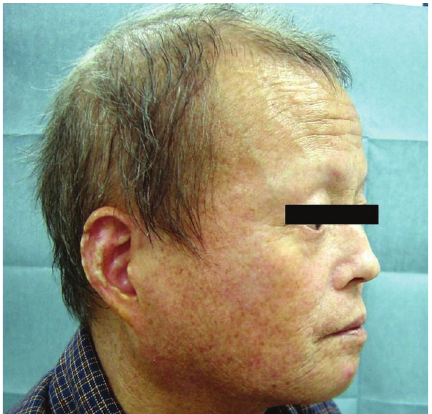
Figure 3: The typical bird-like facial characteristics of patient with Werner’s syndrome.